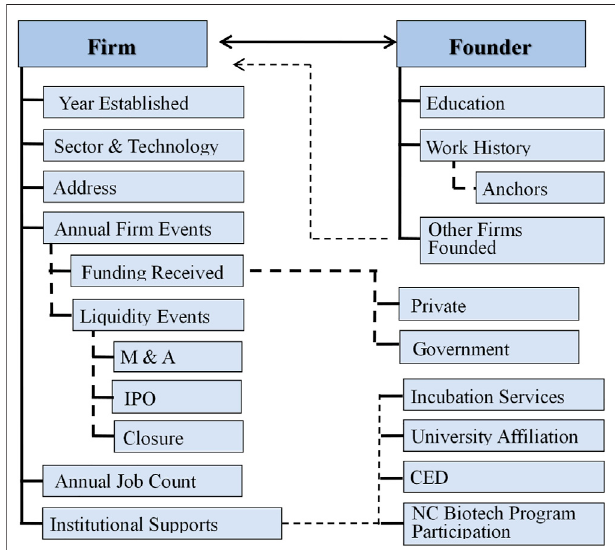
FIGURE 1 | Place database MySQL relational structure. Source: Feldman and Lowe